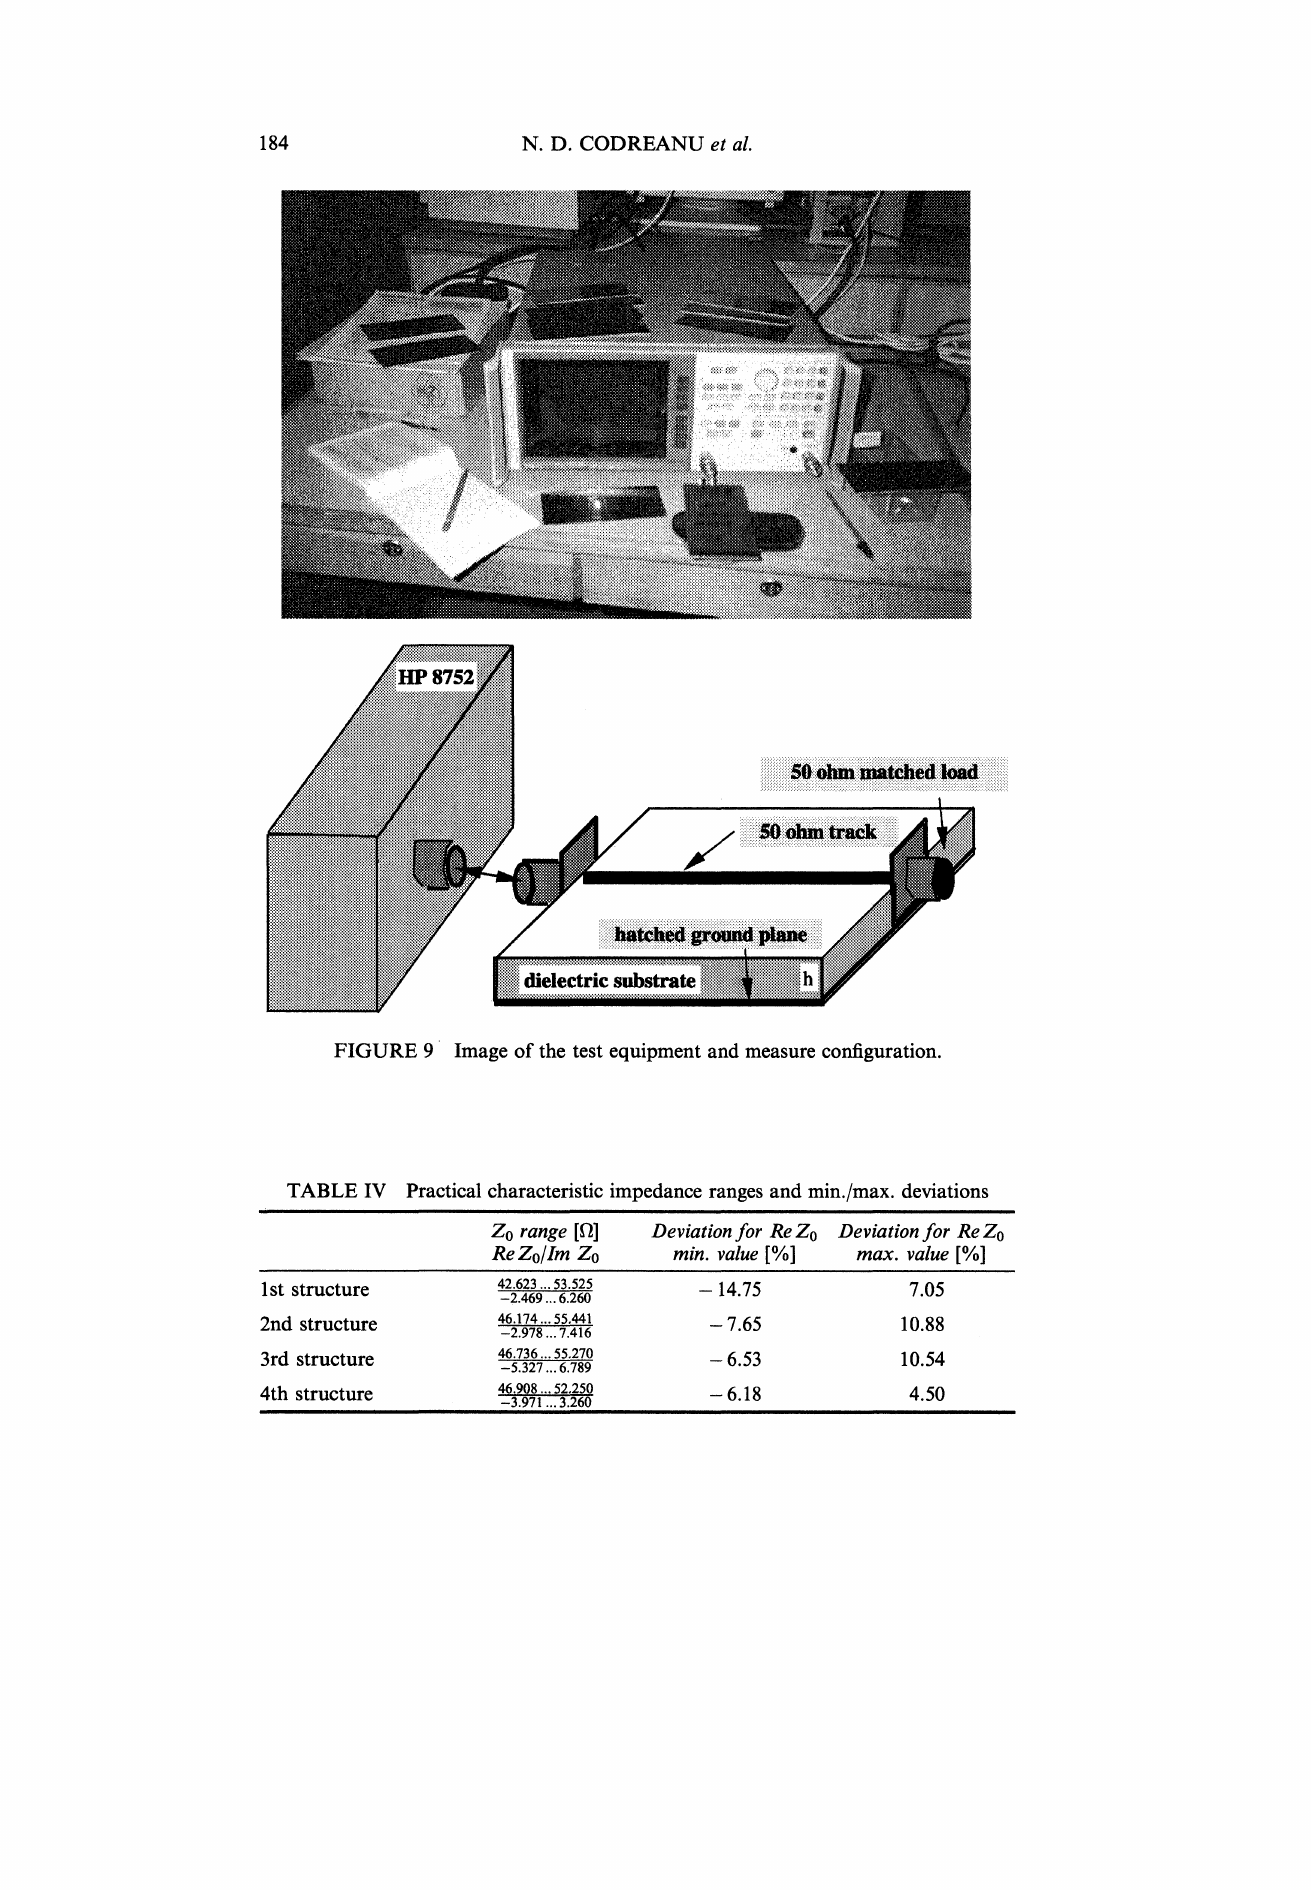
TABLE IV Practical characteristic impedance ranges and min./max,